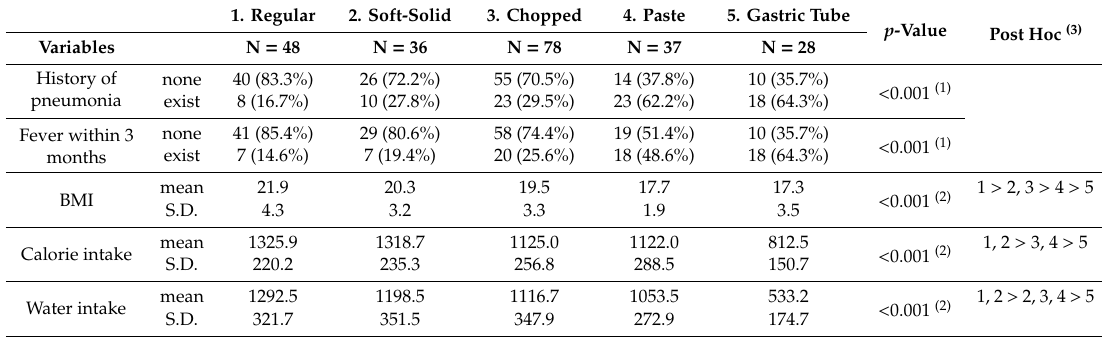
Table 2. Consistency of food substances and physical condition.